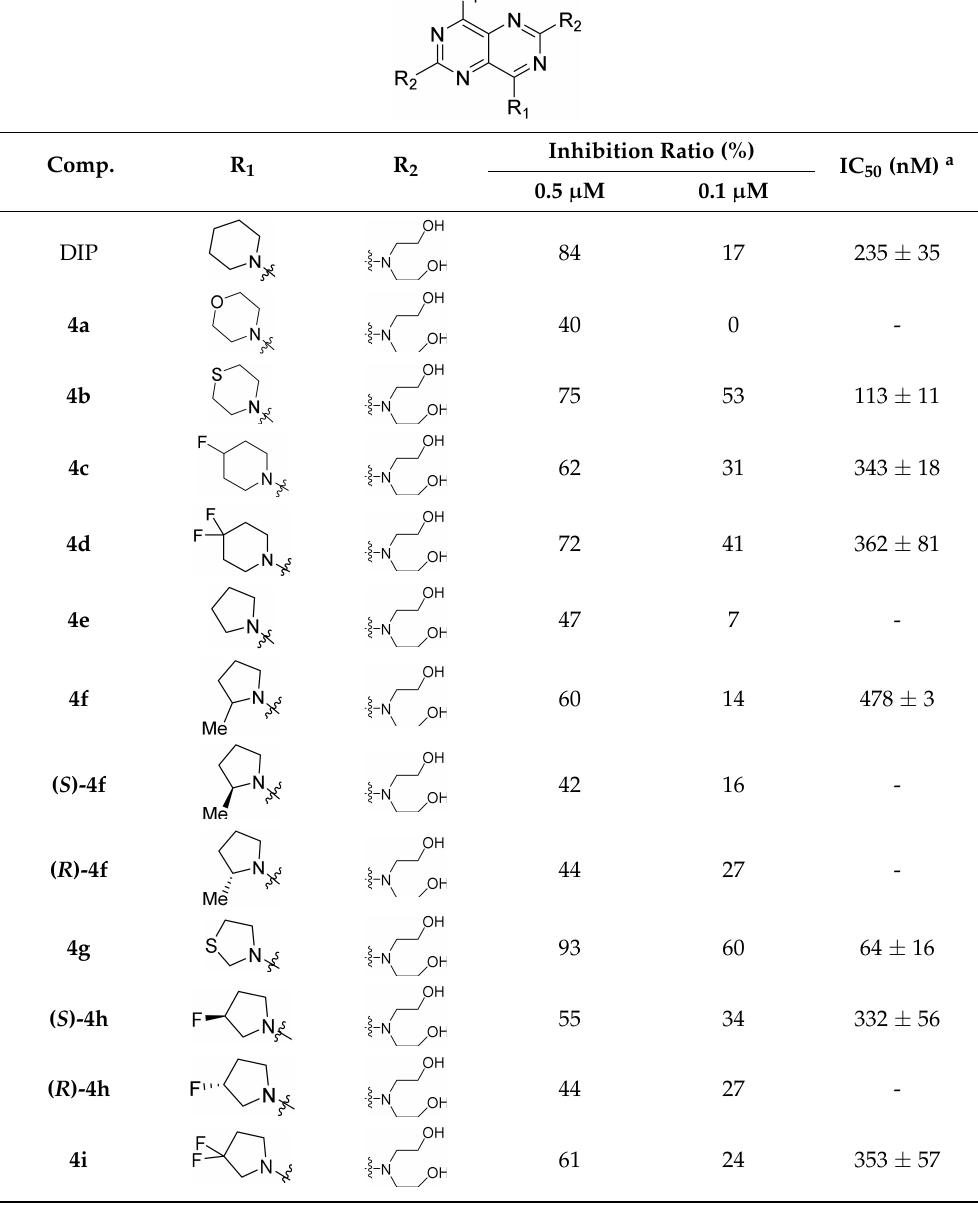
Table 1. The inhibitory activities of the target compounds 4a–i against PDE5.